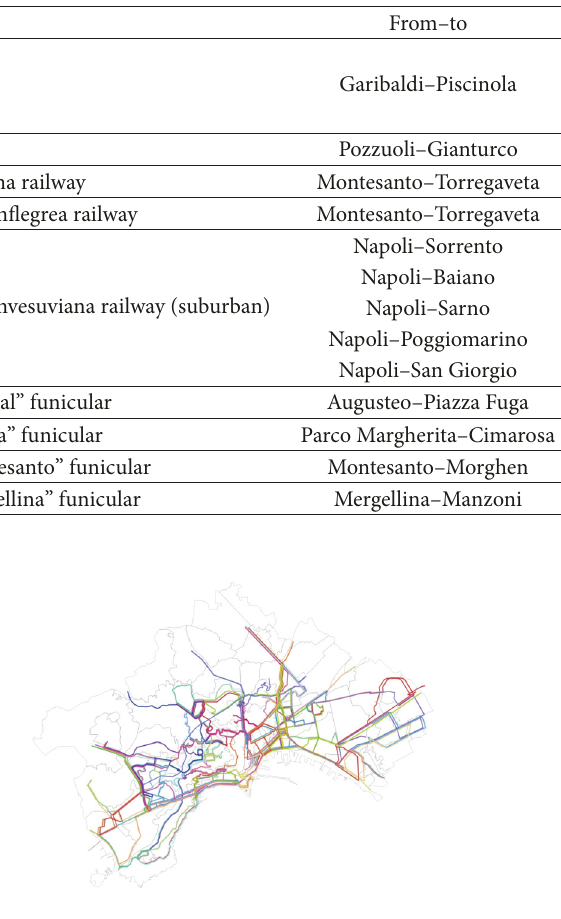
Table 1: Railway lines.